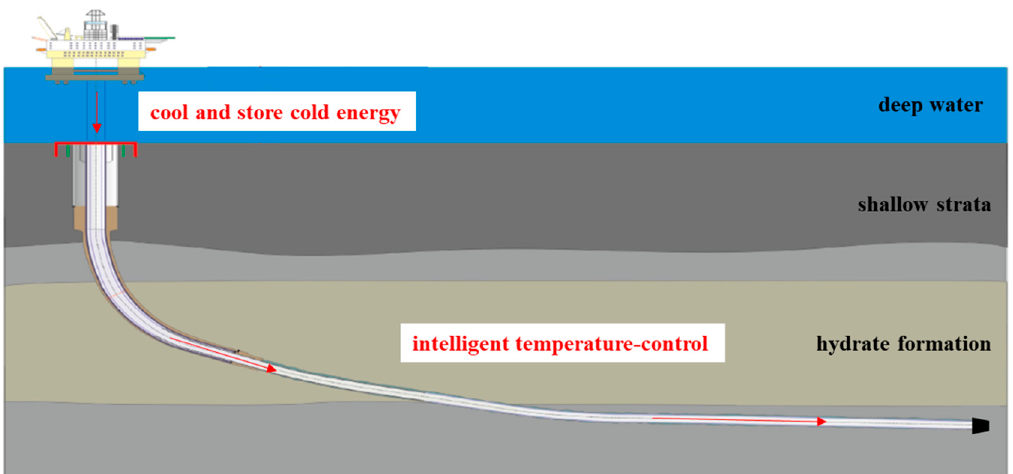
Figure 1. Schematic diagram of microcapsules intelligent temperature-control in hydrate formation (modified from [25]).